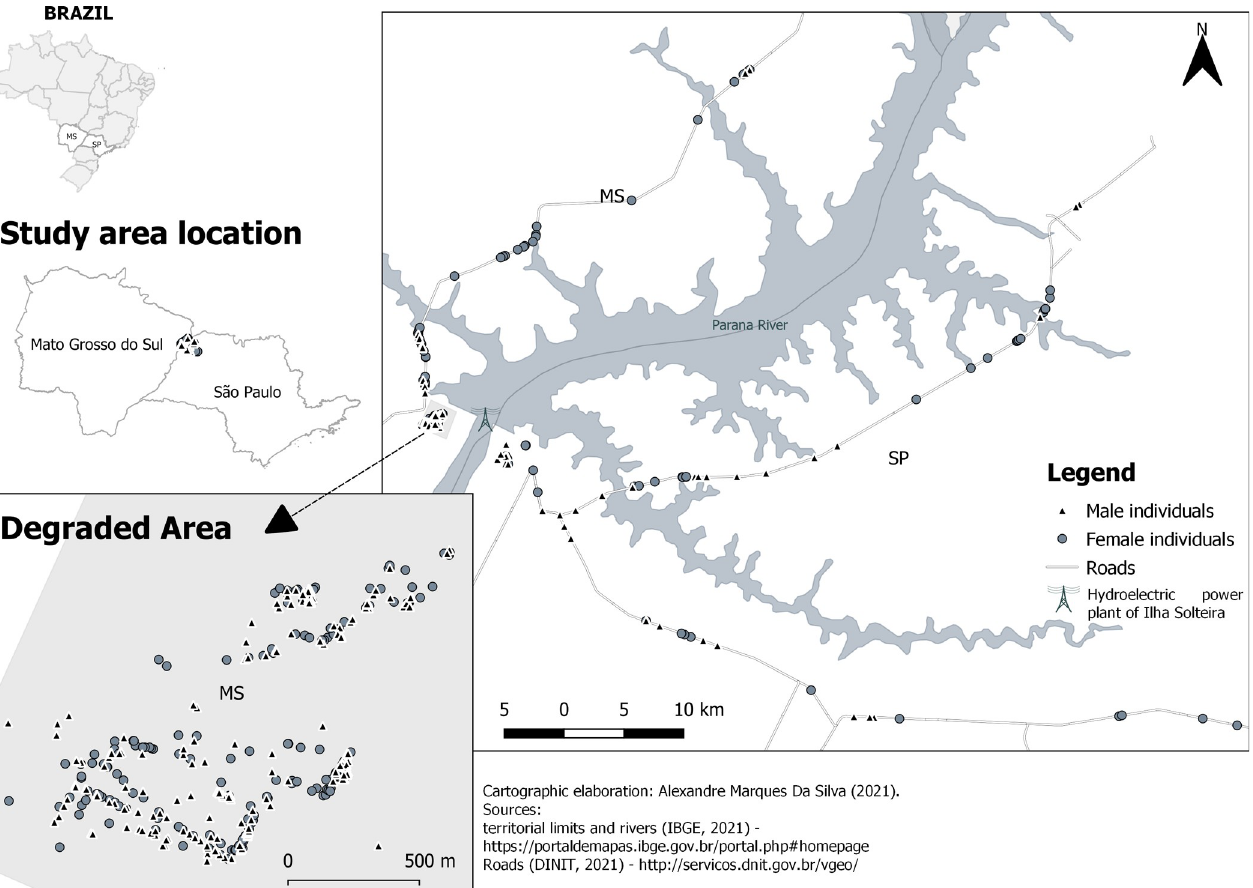
Fig 1. Spatial distribution of Astronium fraxinifolium individuals in the Regenerant Population (RP) and in the states of Mato Grosso do Sul (MS) and S ã o Paulo (SP), Brazil.